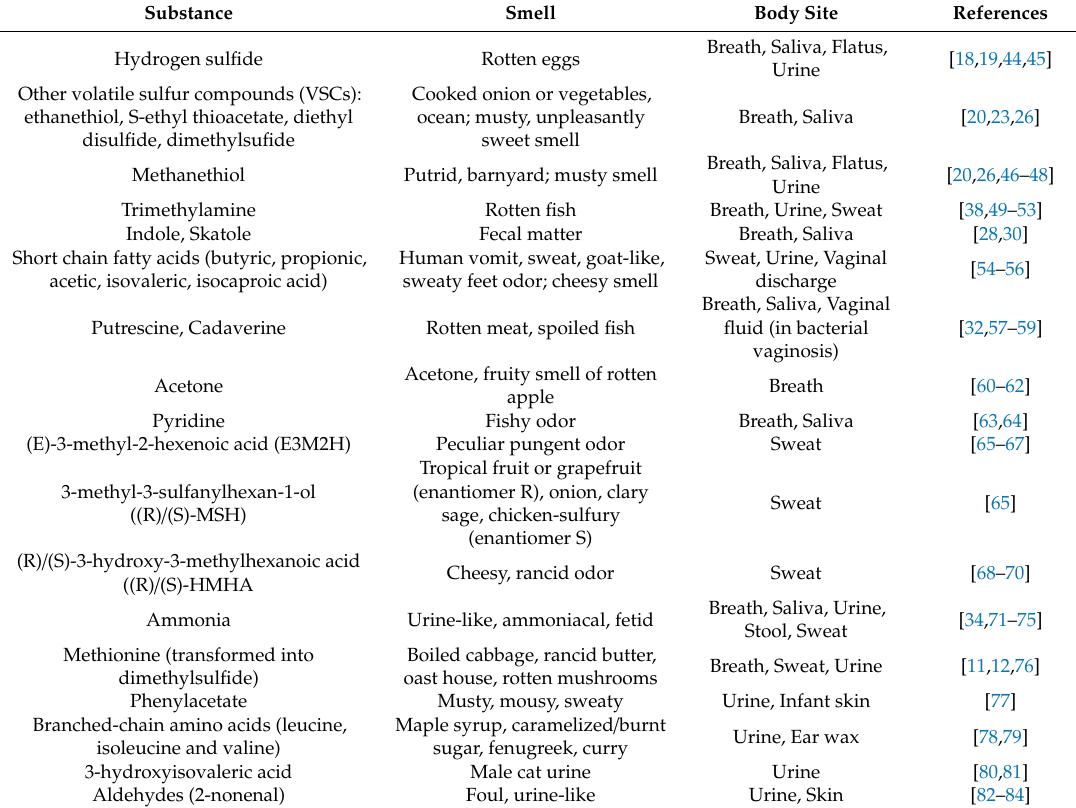
Table 1. Most common bacterial